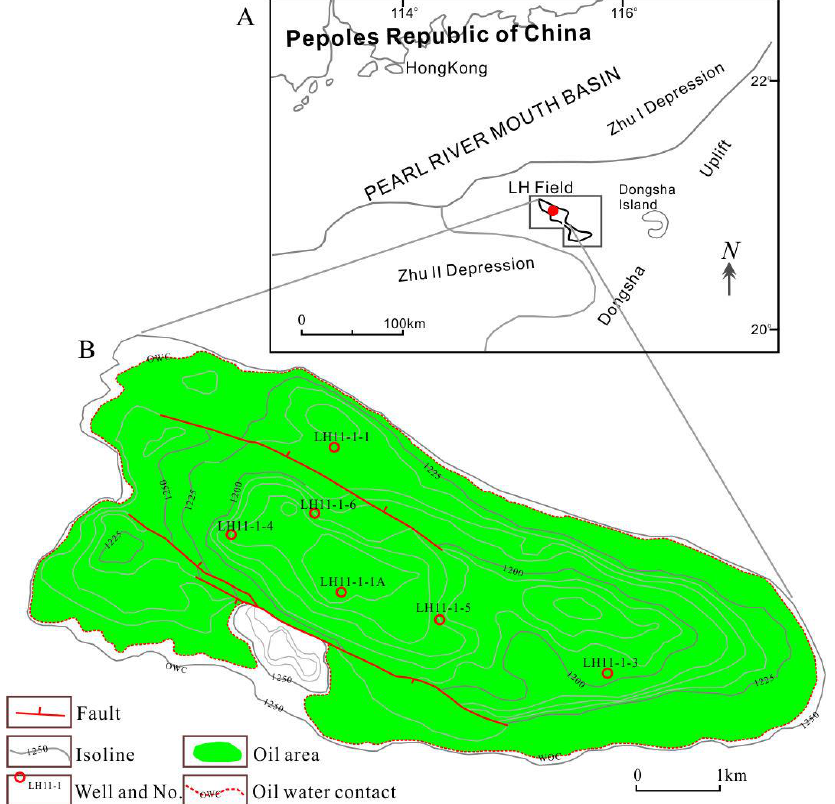
Figure 1. Maps showing geographic setting and reef structure of the top Zhujiang group of LH11-1 oilfield ( A and B , respectively) in PRMB, offshore Guangdong province, southern China. Depths are in meters, and the oil area, oil water contact (OWC) and locations of oil well are also shown in B. A was modified after Sattler, et al. [18], Sattler, et al. [19], Tumer and Hu [20] and B after Zhu and Mi